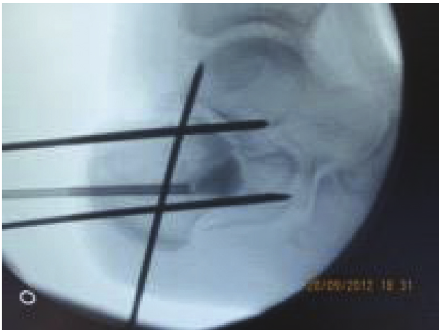
Figure 2: Injection of the bone cement. It is noted that the k-wires positioned distally as a palisade allow the balloon to reduce the subtalar joint.